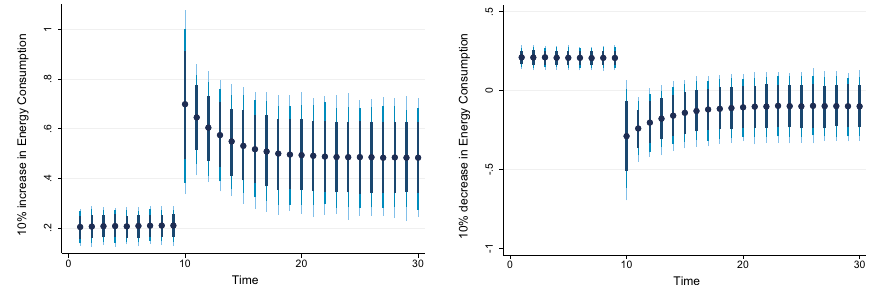
Fig. 4 The Impulse Response Plot for Energy Consumption and CO 2 Emissions. Figure 4 presents an increase and a decrease by 10% in energy consumption and its effect on CO 2 emissions where dots denote average prediction value. The dark blue to light blue line shows 75, 90, and 95% confidence interval, respectively